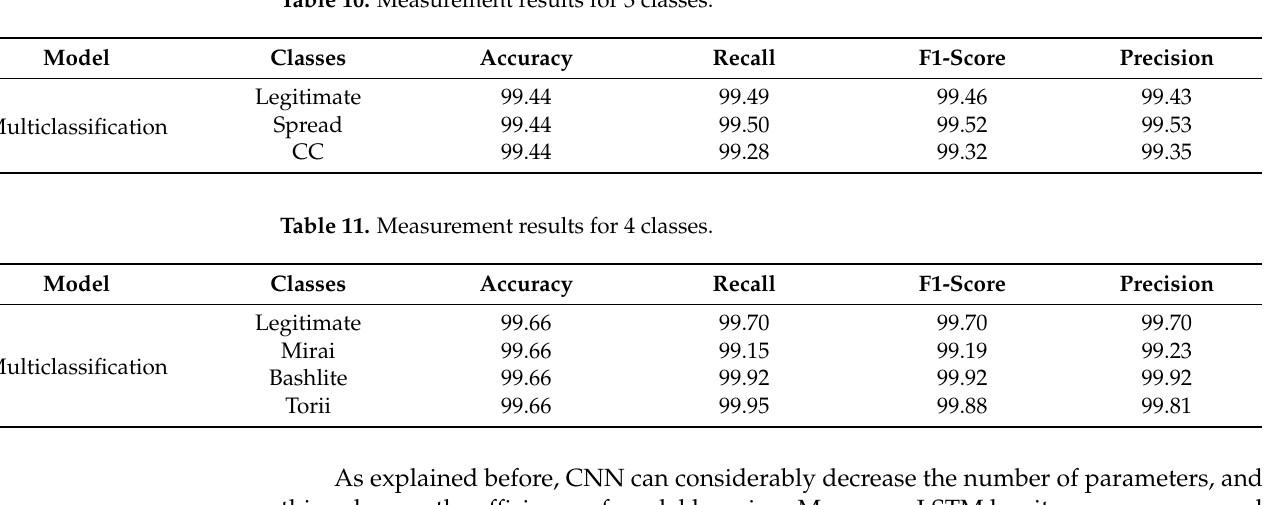
Table 10. Measurement results for 3 classes.